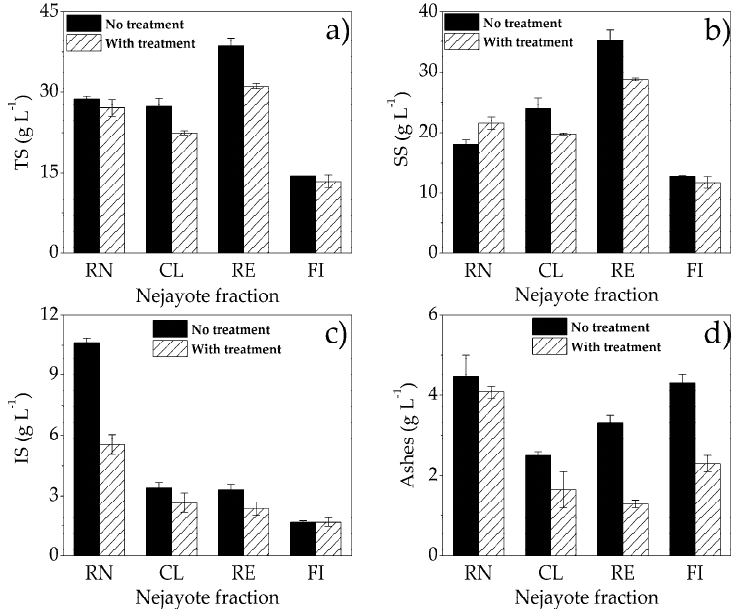
Figure 4. Determination of ( a ) total solids (ST), ( b ) soluble solids (SS), ( c ) insoluble solids (IS) and ( d ) ashes in nixtamalization wastewater crude (RN) and fractions (CL, RE and FI).